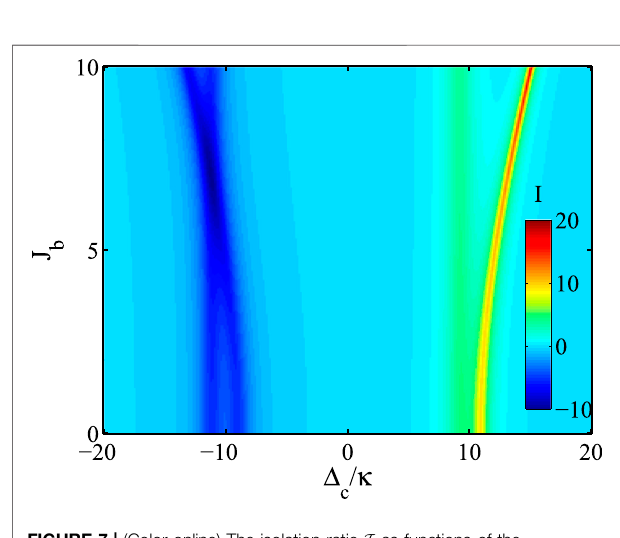
FIGURE 7 | (Color online) The isolation ratio I as functions of the detuning Δ c / κ andthecouplingstrength J b .Theparametersaresetas: κ =5× 10 − 3 ω c , Ω = 0.97 GHz, κ i j , e (cid:1) κ , κ i = 0.5 κ , J a = 2 κ , ϕ a ,cw = 0.5 π , ϕ L ,cw = π , and ϕ π with i = a , b and j = 1, b ,cw = 1.5